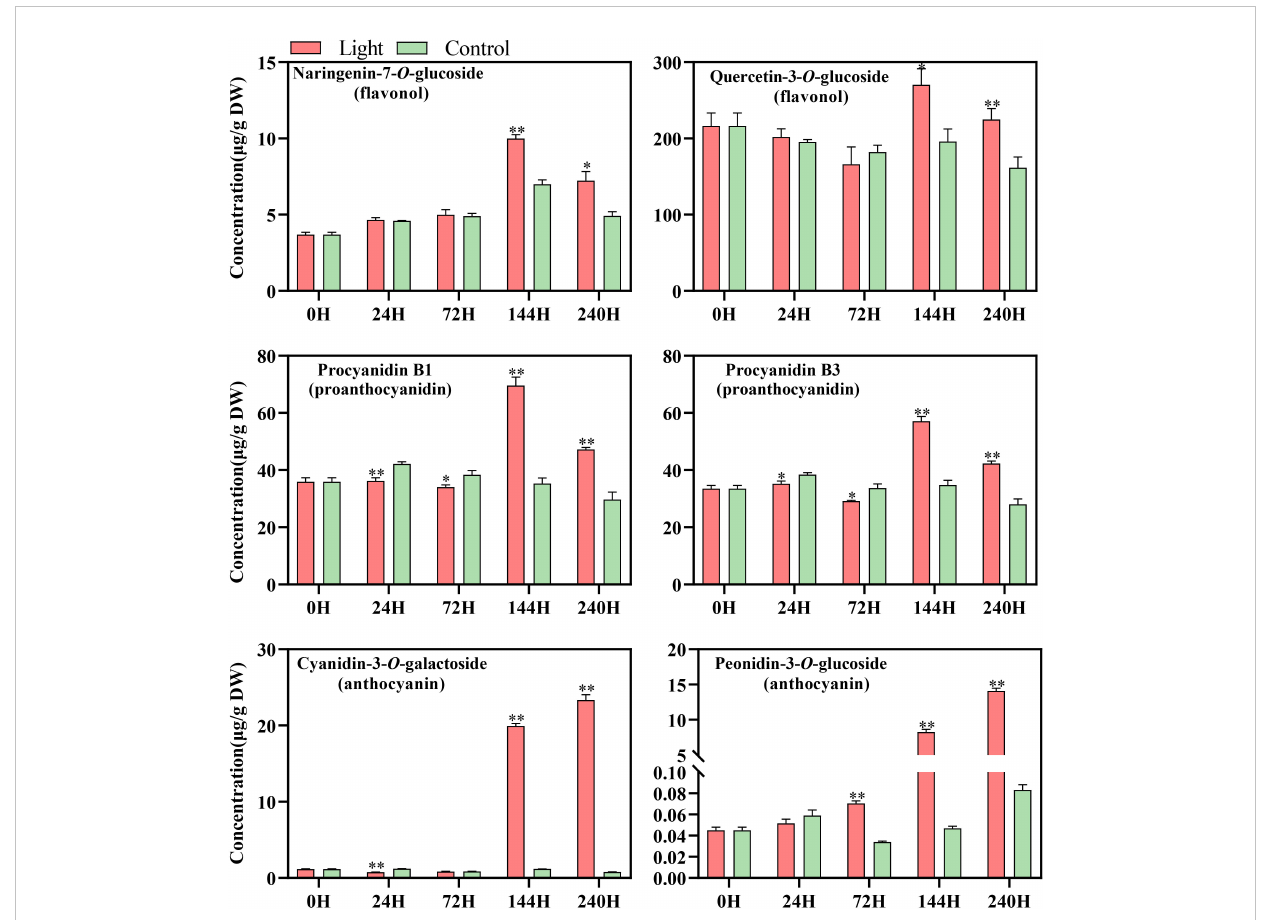
FIGURE 2 Concentration of fl avonoid compounds detected in the fruit skin of light-treated and control (darkness) ‘ Zill ’ mango fruits during different postharvest light treatment stages. Each value represents the mean ± standard deviation of three biological replicates. * indicates signi fi cant difference ( p -value < 0.05), and ** indicates very signi fi cant difference ( p -value < 0.01) between control and treatment, as determined by Student ’ s t